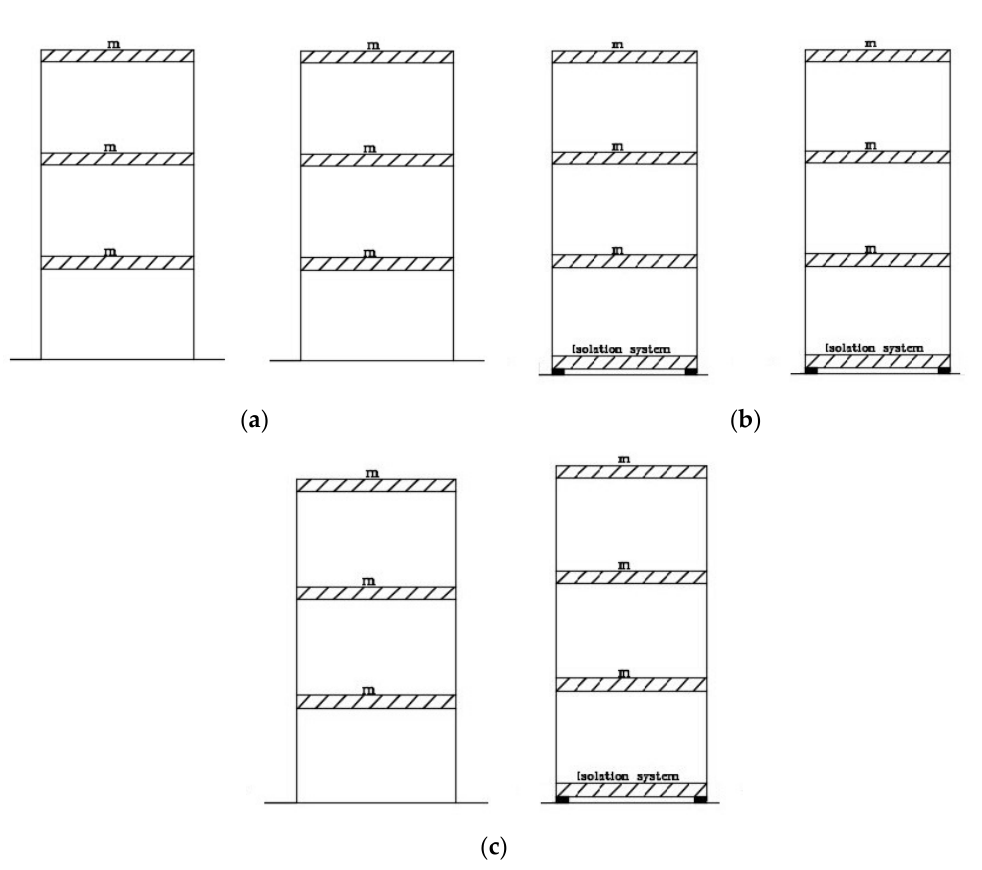
Figure 1. Arrangement scheme of two three ‐ story models investigated in the numerical study (where m is a story mass): ( a ) two non ‐ isolated; ( b ) two isolated; ( c ) one non ‐ isolated and one isolated.